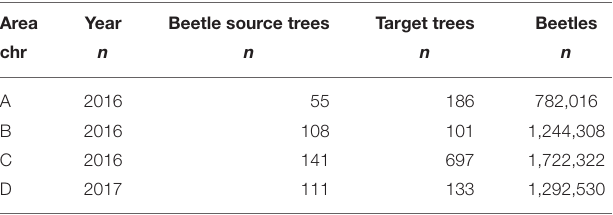
TABLE 2 | Characteristics of research areas used for the calibration of